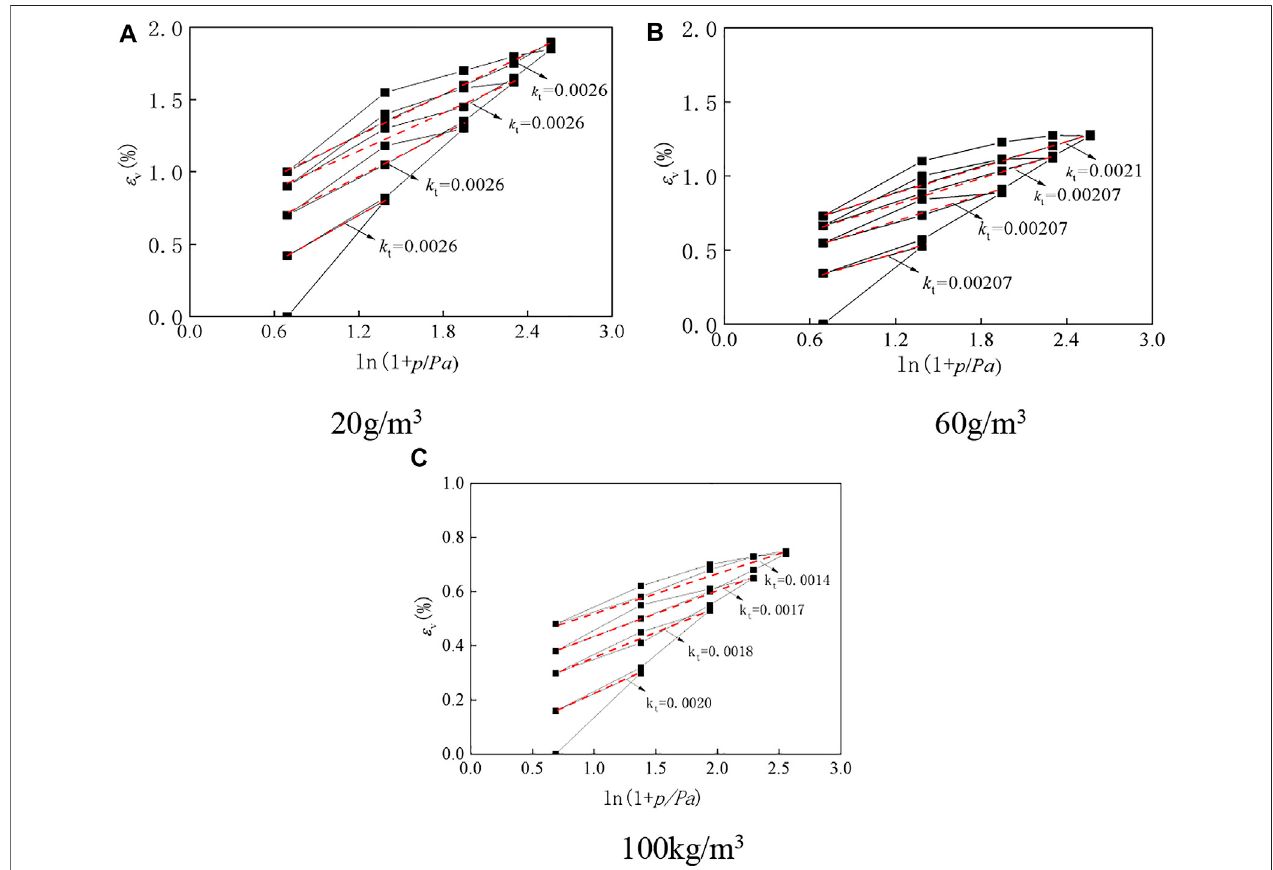
FIGURE 9 | The relation between ε v and ln (1 + p/Pa). (A) 20 g/m3 (B) 60 g/m3 (C) 100 g/m 3 .